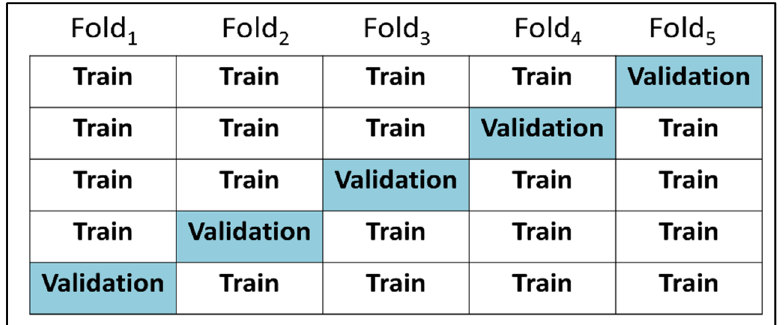
Figure 5. Five-fold cross-validation. This figure showed the way of five-fold cross-validation and how the dataset was split into five